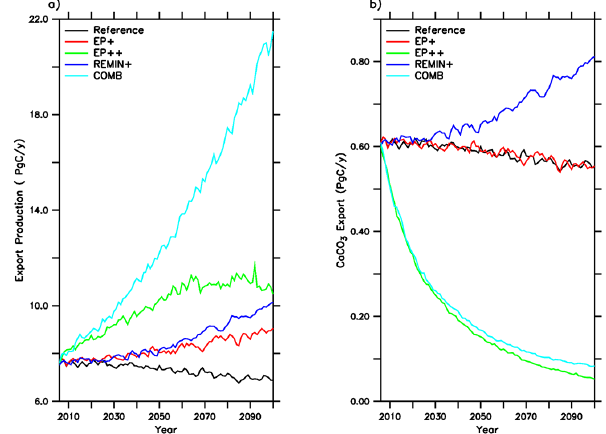
Figure 7. (a) Projected global export of POC from the upper 100m of the ocean. (b) Projected global export of PIC from the upper 100m of the